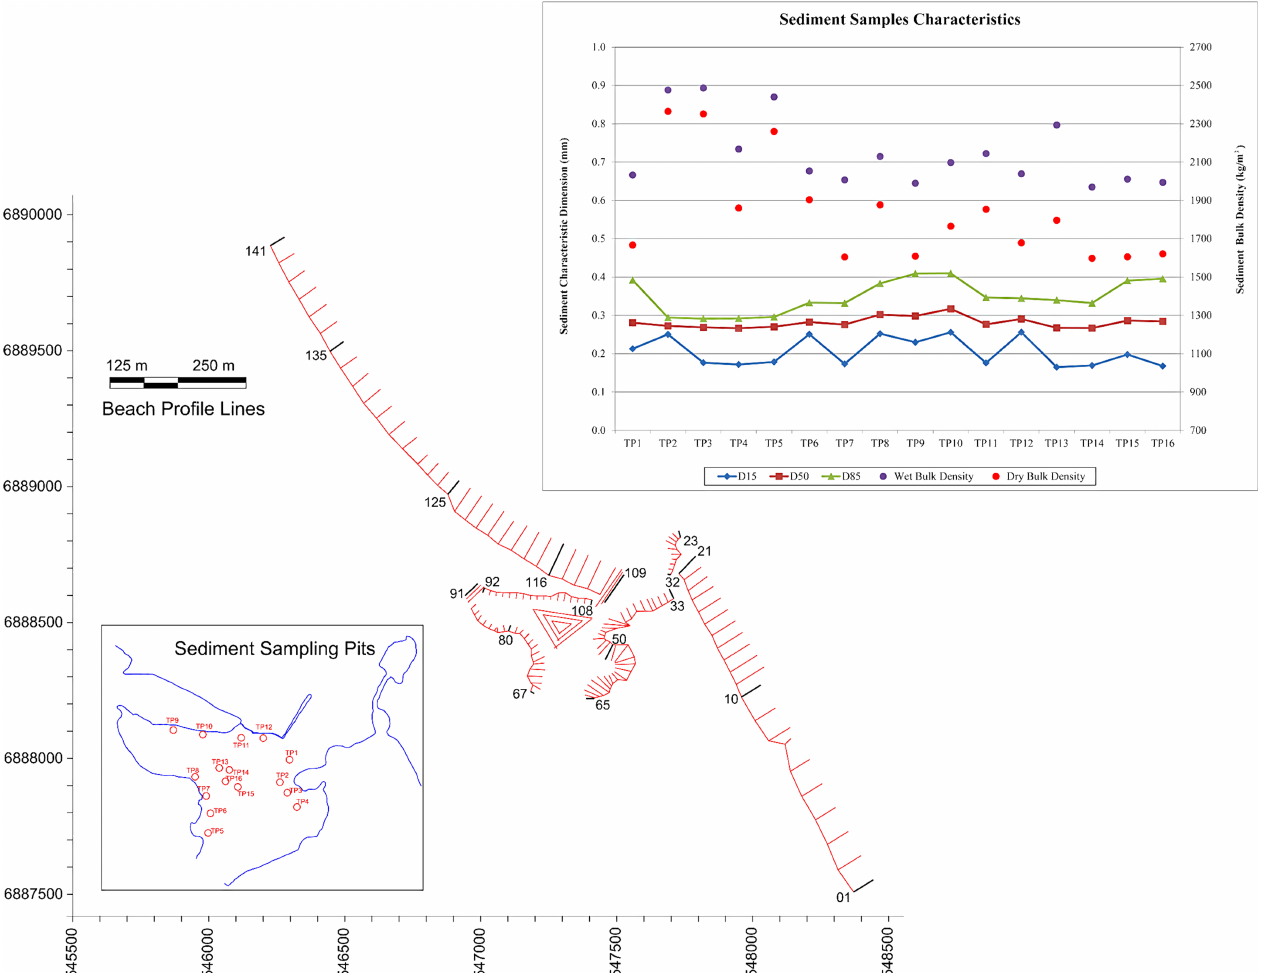
Fig. 7. Location of beach-profile lines in addition to sediment sampling pits locations and